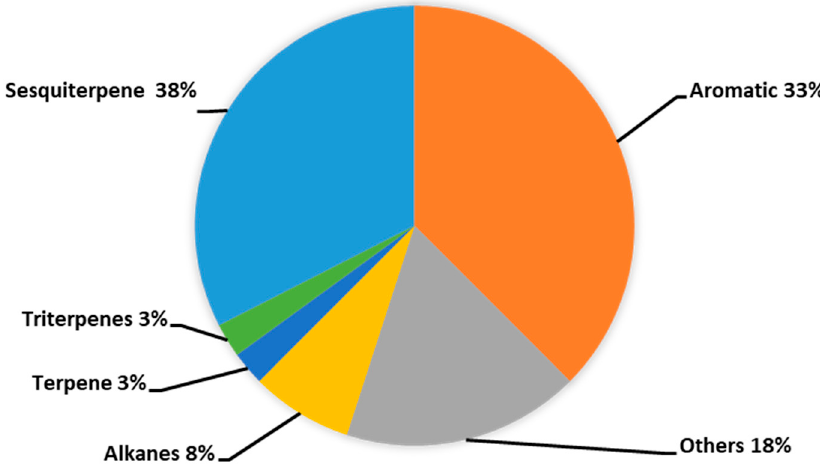
Figure 4. Pie chart showing chemical classification of 40 compounds identified in the incense smoke from Kynam agarwood.